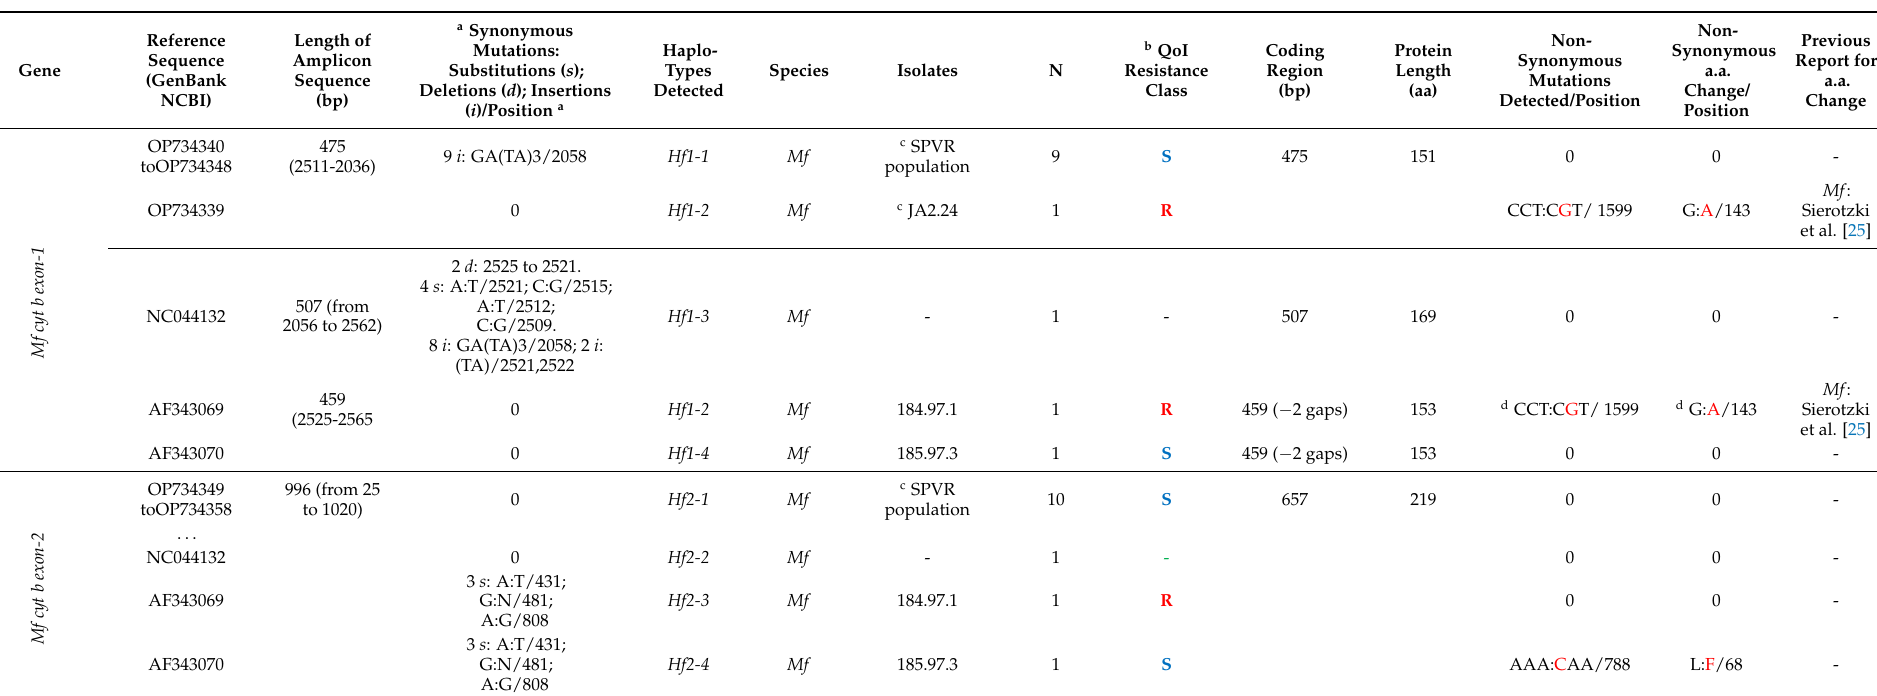
Table 5. Summary of variation at cytochrome b (cyt b) genes from field isolates of Mycosphaerella fijiensis strains from Brazil with distinct resistance phenotypes to the QoI fungicides azoxystrobin and